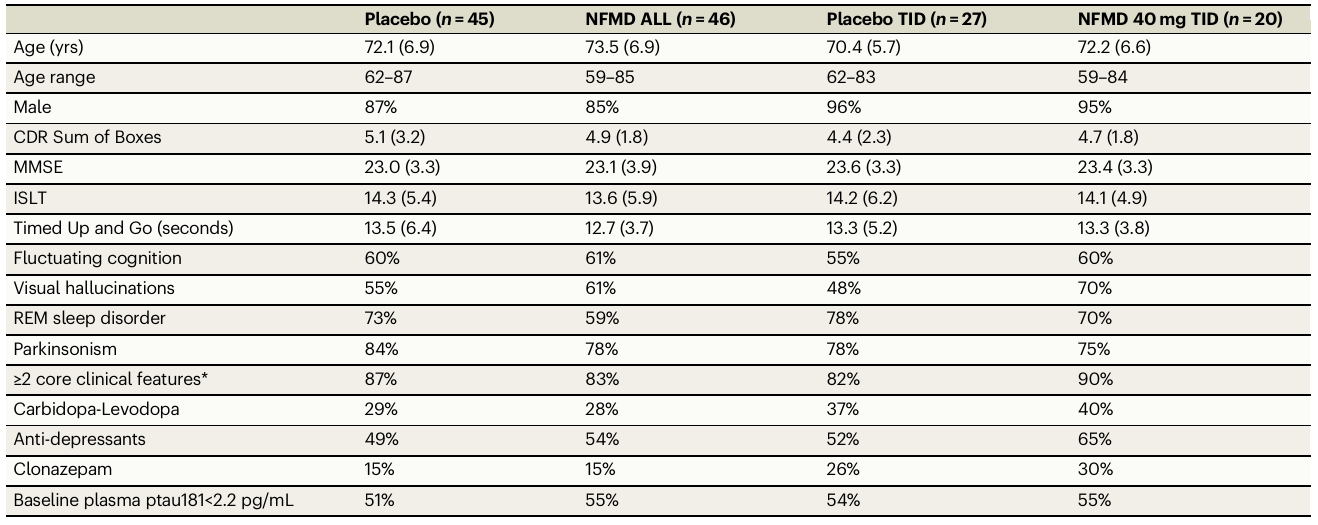
Table 1 | Baseline characteristics in the clinical study